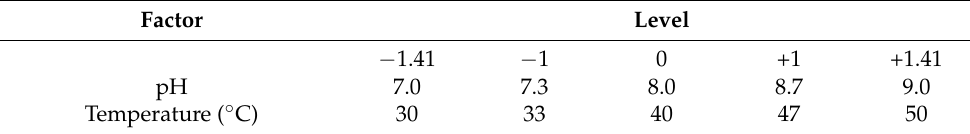
Table 1. Ranges of the factors investigated in the experimental